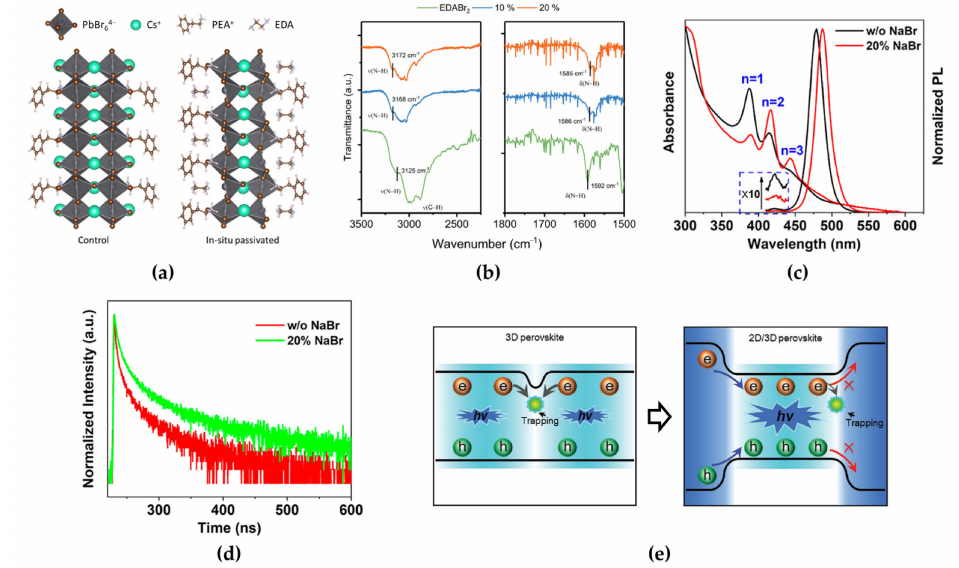
Figure 8. ( a ) Structures of controlled and passivated quasi-2D ( n = 2) perovskites. Reprinted with permission from [63], Copyright 2020 American Chemical Society. ( b ) Fourier-transform infrared (FTIR) absorption spectra of thin films ( ν (N − H), ν (C − H): N − H and C − H bond stretching; δ (N − H): N − H scissoring). Reprinted with permission from [63], Copyright 2020 American Chemical Society. ( c ) Absorption and PL spectra of quasi-2D perovskites with rearranged phase distribution. Reprinted with permission from [64], Copyright 2020 American Chemical Society. ( d ) PL decay with a 375 nm excitation wavelength for quasi-2D perovskite films with and without 20% NaBr. Reprinted with permission from [64], Copyright 2020 American Chemical Society. ( e ) Schematic of carrier recombi- nation dynamics depending on 3D ( left ) and 2D/3D ( right ) structures. Reprinted with permission from [65], Copyright 2020 John Wiley and